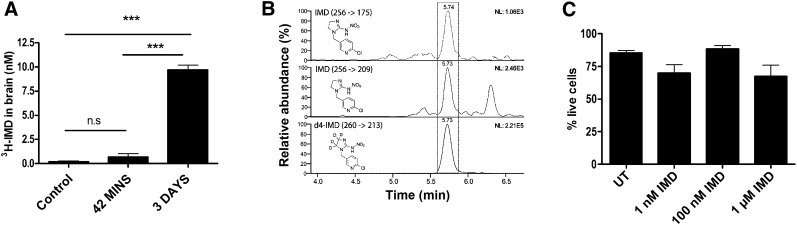
Imidacloprid accumulation in the brain does not affect neuronal viability. A) Bumblebees were fed radioactive imidacloprid (3H-IMD) for times indicated, and brains (10 bees, n = 3) were isolated and counted by scintillation to determine imidacloprid concentration. ***P < 0.001 (1-way ANOVA with Bonferroni’s multiple comparison test). B) Bumblebees were fed imidacloprid for 3 days, and the brain was excised and analyzed by stable isotope dilution LC/MS to determine the concentration of active ingredient [imidacloprid (transition 256→175 and 256→209)] with an internal standard [d4-imidaclorid (260→213, 500 pg on-column)]. Examples of ion chromatograms from a bumblebee brain extract are shown. C) Bumblebee brain neurons (DIV 3–10) were exposed to imidacloprid (1 nM to 1 μM) for 24 hours, and cell viability was determined using calcein AM/EthD-1 staining (∼8–11 fields, ∼50 neurons per field, n = 3).